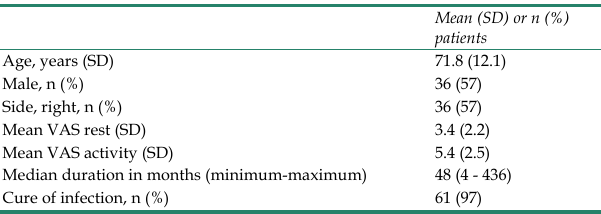
Table 1. Patient characteristics of the study population (n = 63)